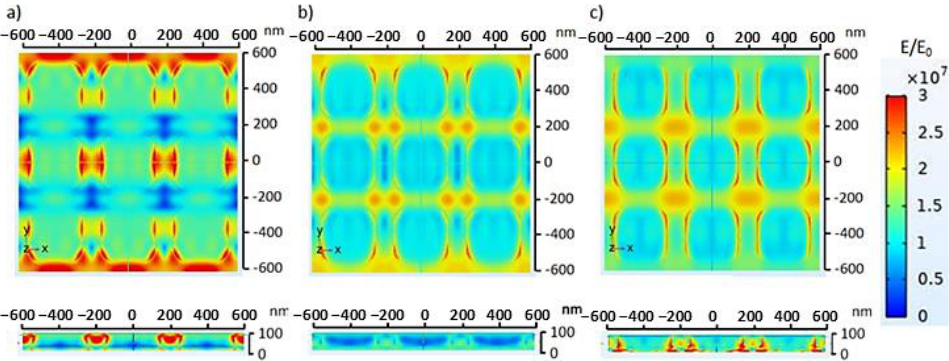
Figure 7. Top view and side view of the electric field distribution on the ZnO nanosquare irradiated with electromagnetic waves in normal glucose concentration in blood medium with a wavelength of ( a ) 450 nm, ( b ) 550 nm, and ( c ) 650 nm.